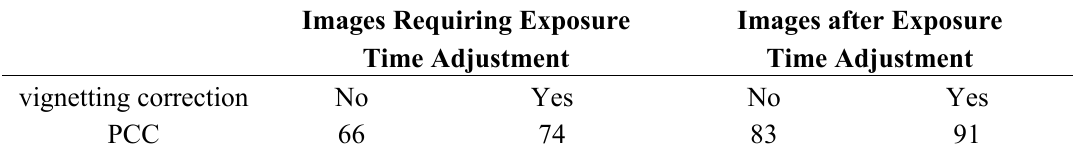
Table 2. Averaged PCC values for the images analyzed with and without exposure time adjustment and with and without vignetting